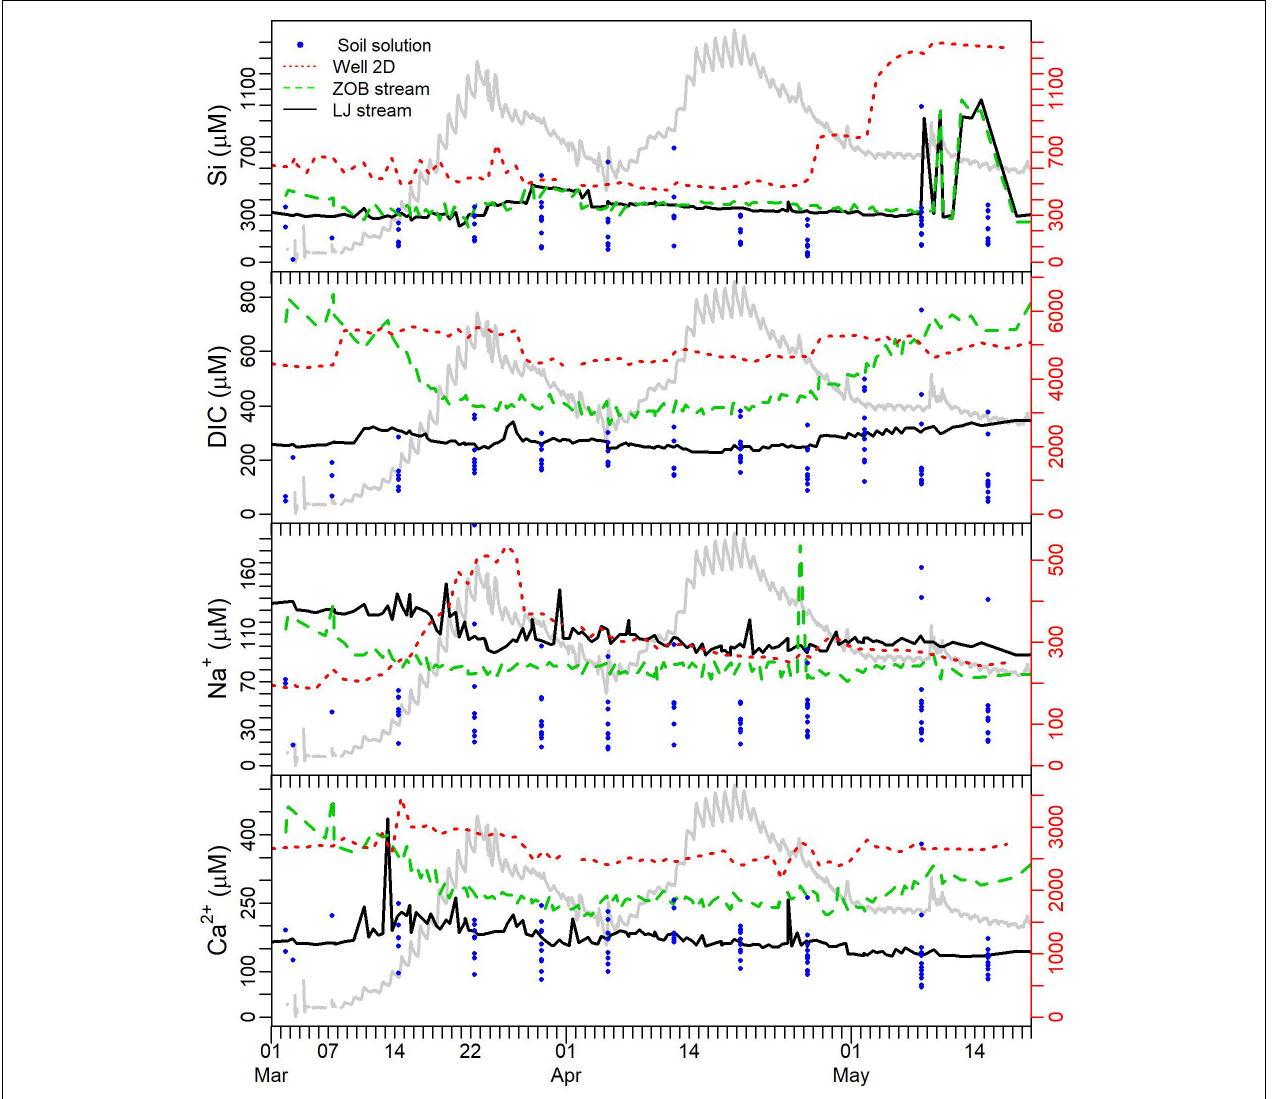
FIGURE 3 | Time series of Si, DIC, Na and Ca in soil solution (filled blue circles), groundwater monitoring Well 2D (dotted red line), ZOB flume (dashed green line) and LJ flume (solid black line). The LJ hydrograph trace (from Figure 2F ) is shown in light gray in the background (no axis scale) for temporal